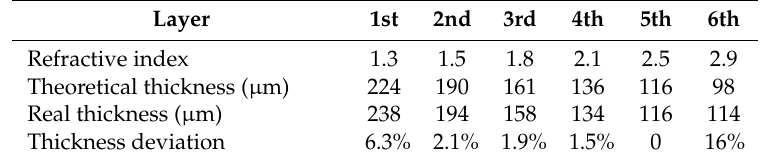
Table 1. Refractive index and thickness of each layer in the flat six-layer AR structure.